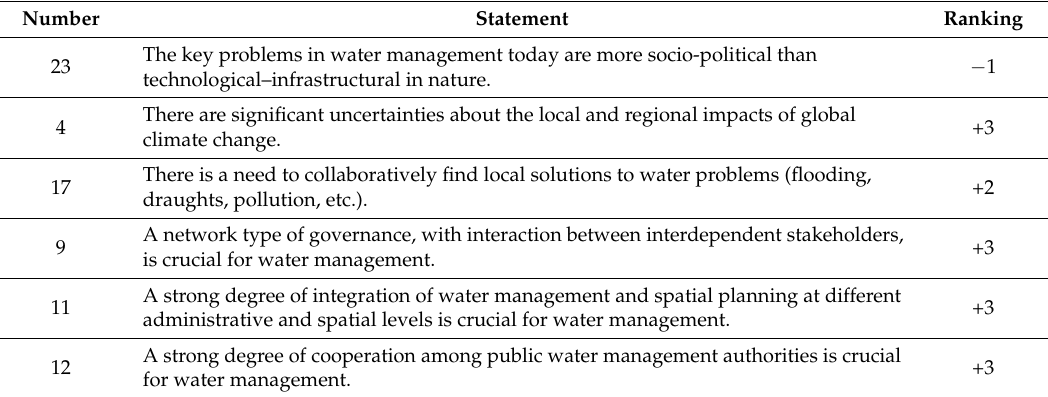
Table 7. Distinguished statements about IWRM in frame NL4.